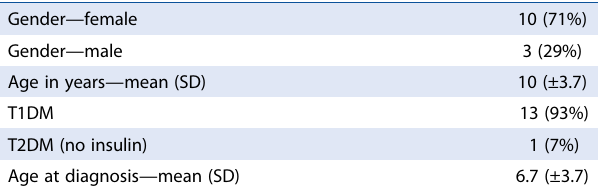
Table 2: Child characteristics ( n = 14) Gender — female